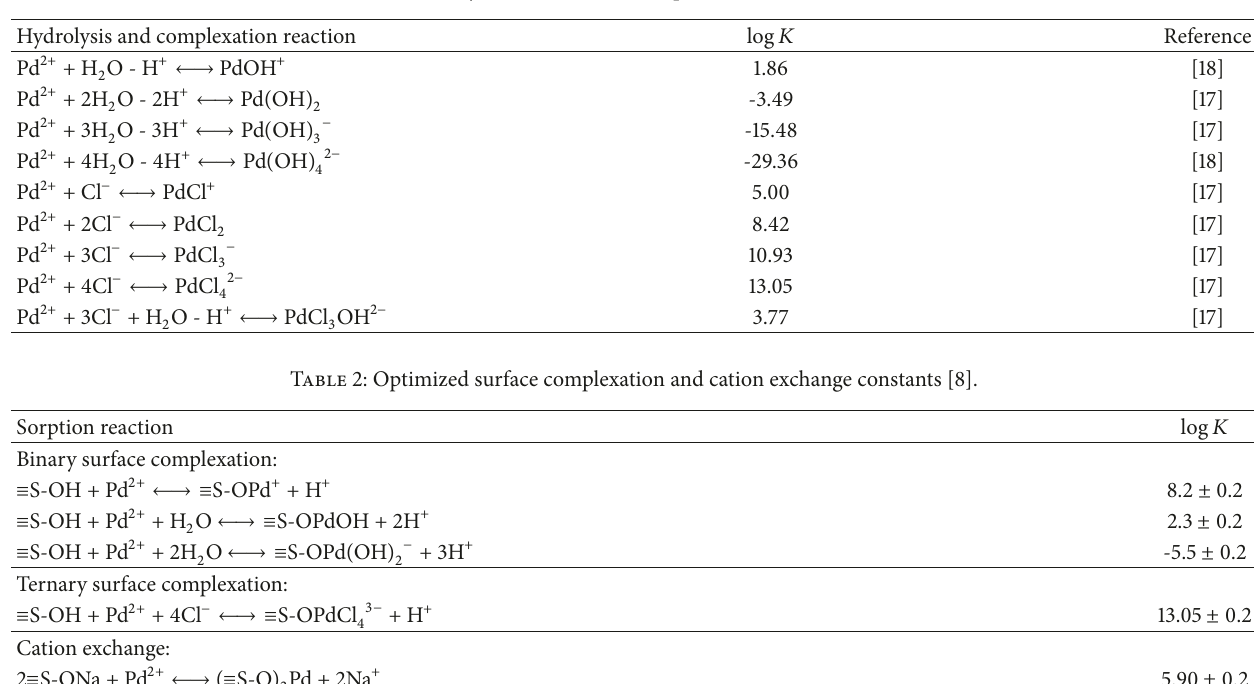
Table 1: Thermodynamic data of Pd(II) species used in this work [19, 20].